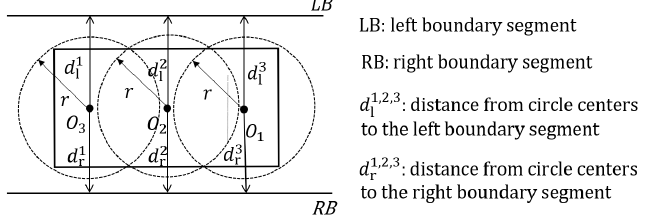
Figure 6. Corridor boundary-collision checking in trajectory